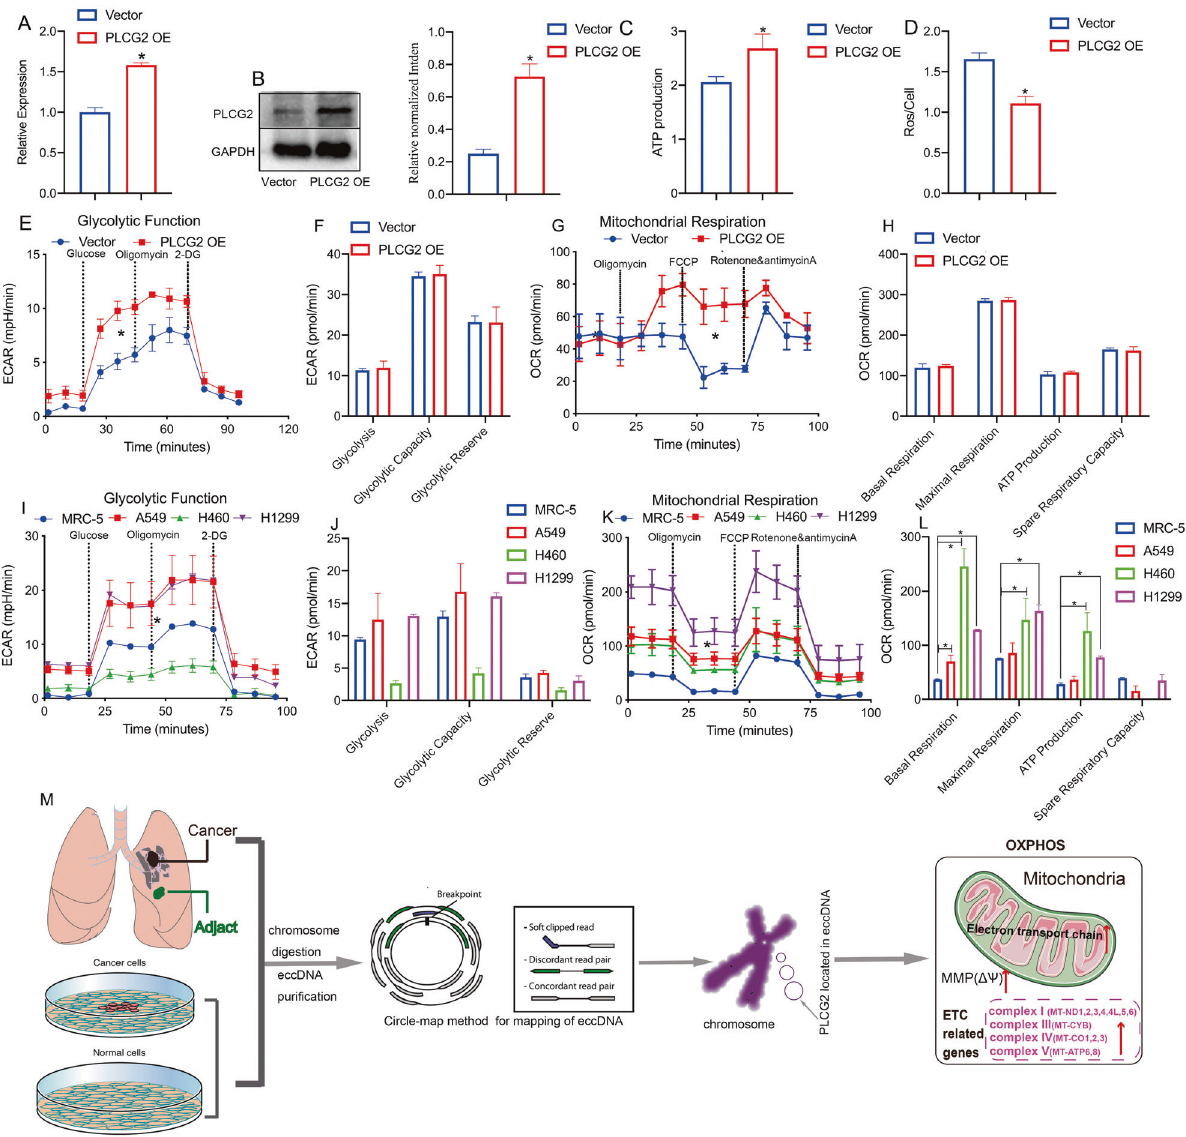
Fig. 6 High level of PLCG2 in NSCLC cells contributed to the higher mitochondrial respiration. A , B The overexpression of PLCG2 in H460 cells after transfection, con fi rmed by qPCR and western blotting. C Mitochondrial ATP synthesis in the PLCG2 OE group by the ATP detection kit. D The production of reactive oxygen species (ROS) in the PLCG2 OE group. E – H The glycolytic function and mitochondrial respiration of H460 cells in PLCG2 OE group, as determined by a Seahorse XF Analyzer. I – L The glycolytic function and mitochondrial respiration of H1299, A549, H460 and MRC-5, with different levels of PLCG2, as determined by a Seahorse XF Analyzer. M Schematic representation of the role and mechanism of eccDNAs in the metastasis of NSCLC